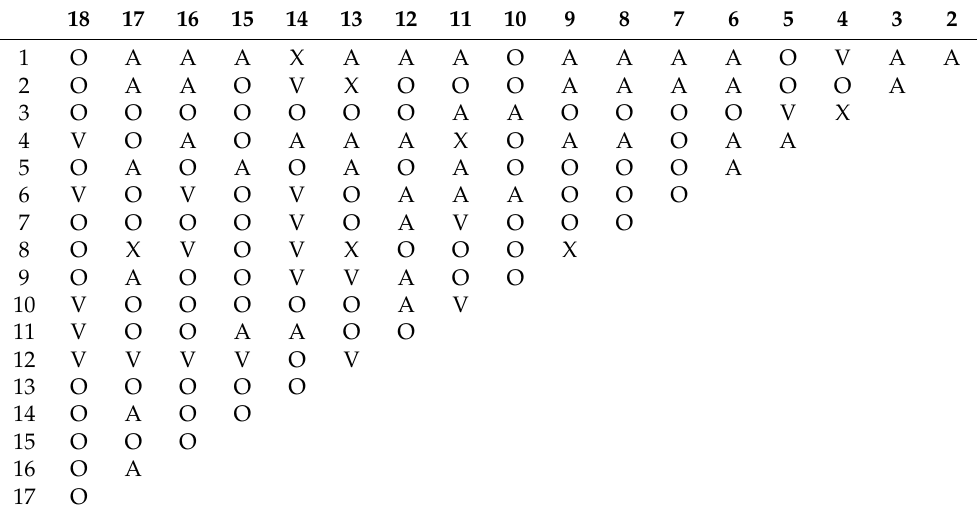
Table 3. Structural self-interaction